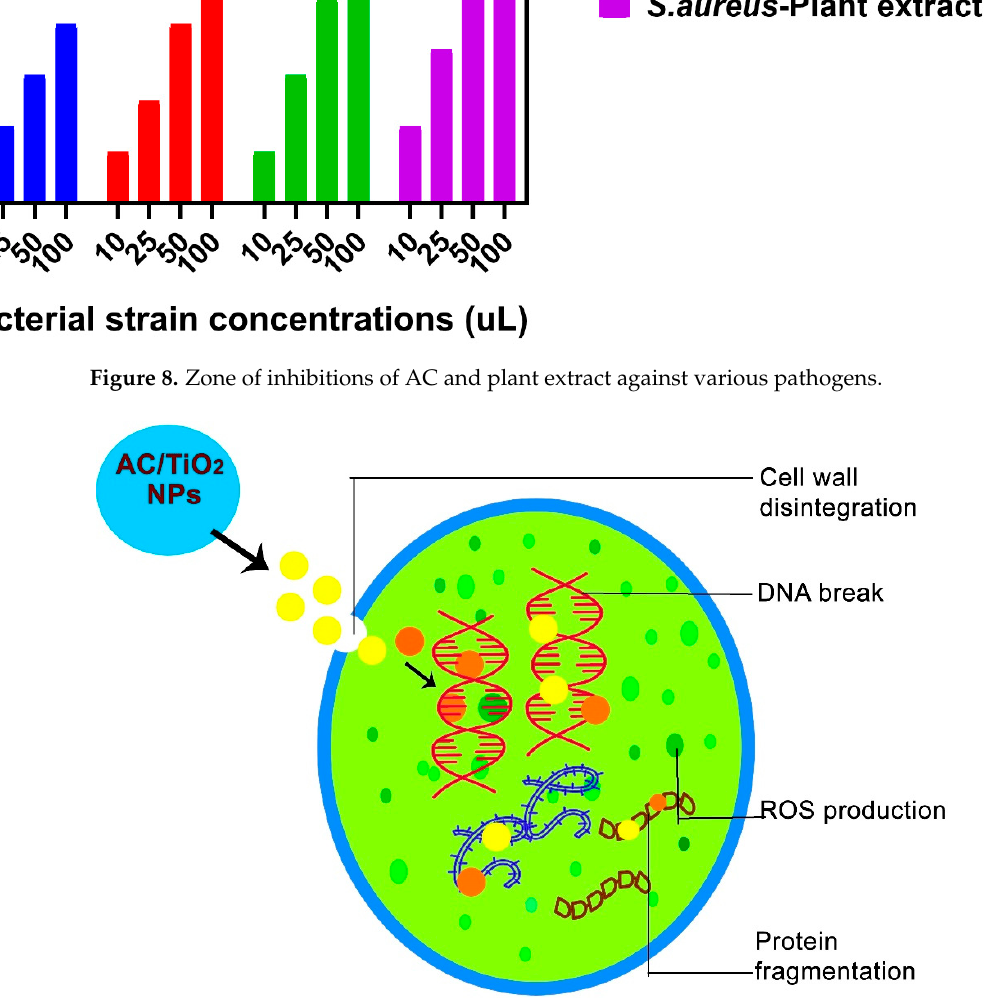
Figure 9. Antibacterial activity